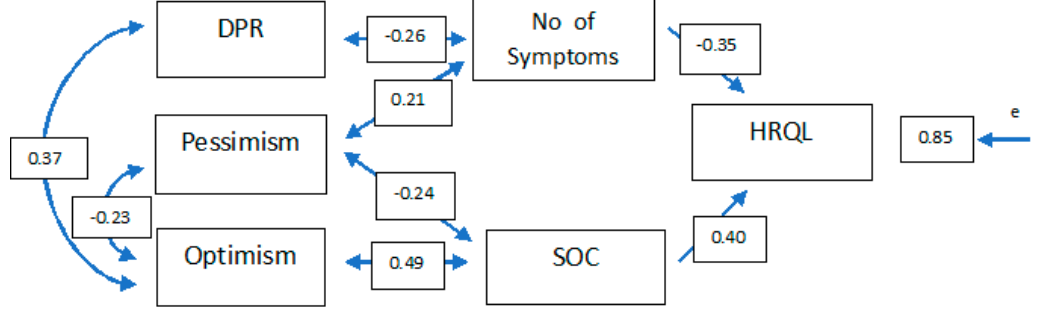
Figure 2. Final model of the relationship between SOC, number of symptoms, and HRQL analysed by contrast. DRP: Doctor–patient relationship; SOC: Sense of coherence; HRQL: Health-related quality of life.